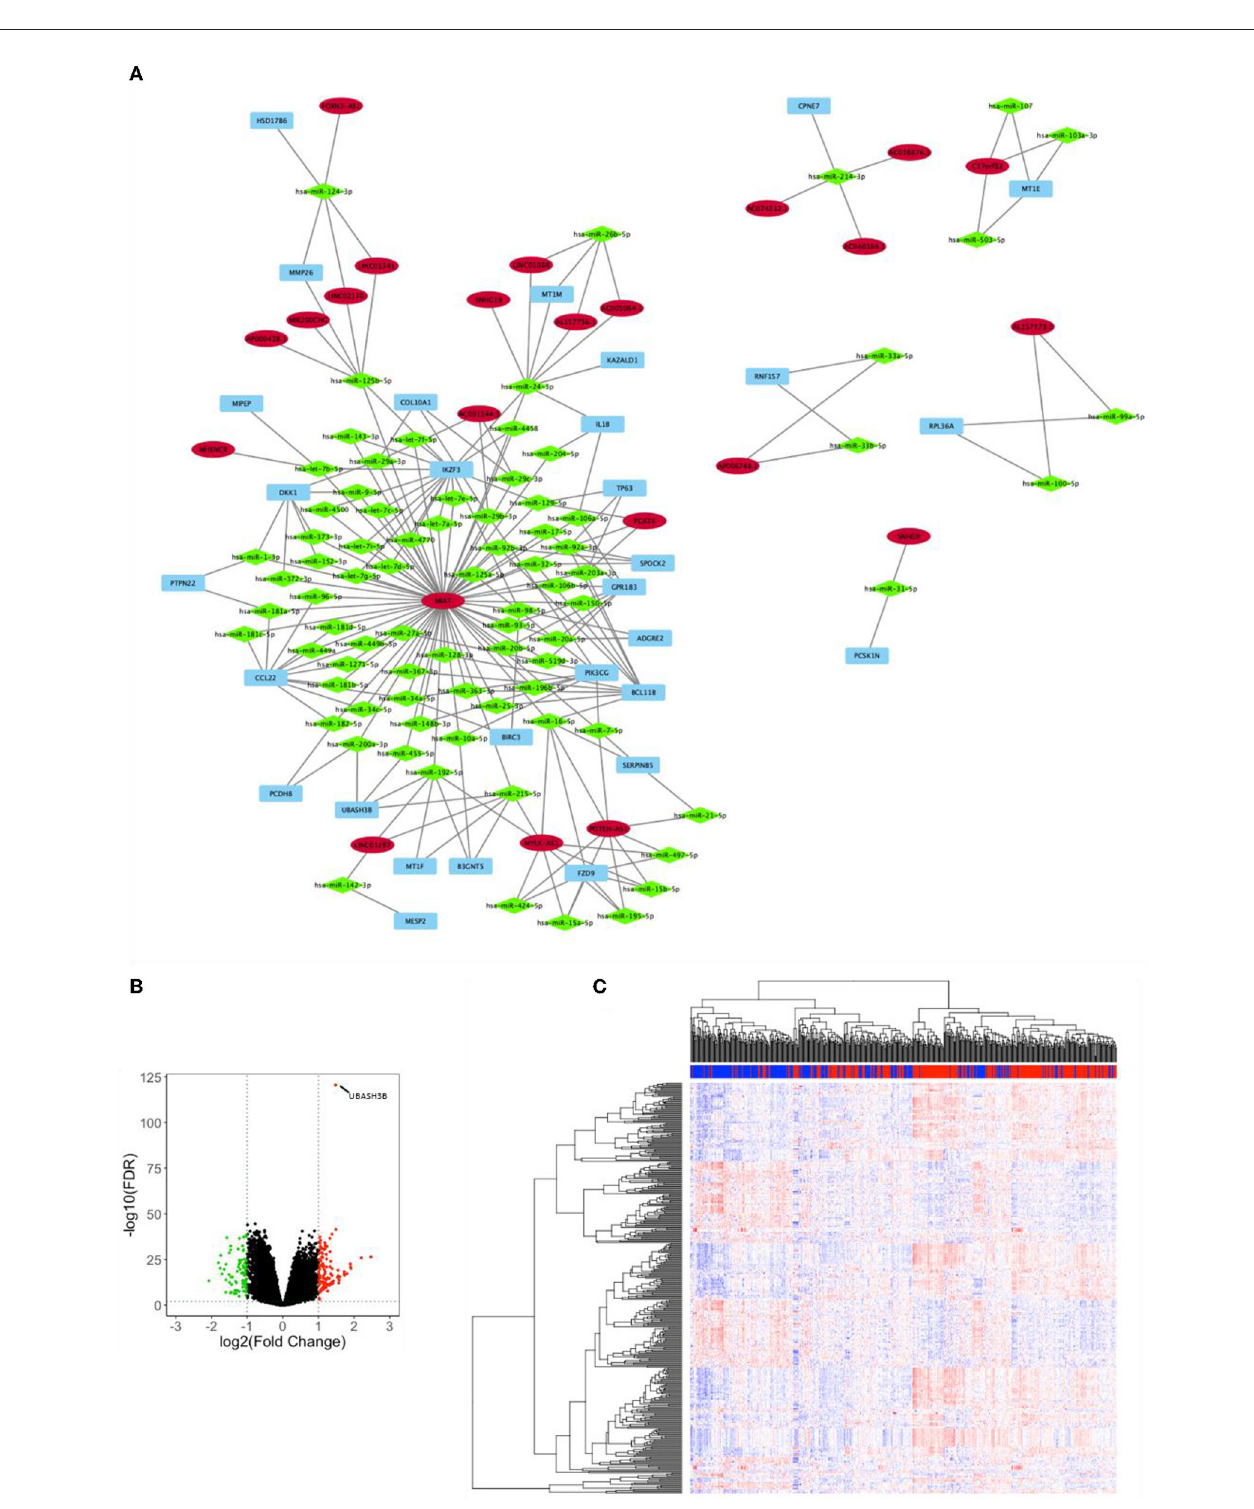
FIGURE 2 | (A) lncRNA-miRNA-mRNA network was constructed from R package of GDCRNATools according to different UBASH3B expression levels and visualized by microsoft Cytoscape. Blue, mRNA; Green, miRNA; Red, lncRNA. (B) Volcano plot of differentially expressed mRNAs and lncRNAs is based on differences in expression levels of UBASH3B. (C) Heatmap of mRNAs and lncRNAs in TCGA-PRAD according to different UBASH3B expression level (Blue, samples with low UBASH3B expression; Red, samples with high UBASH3B expression).